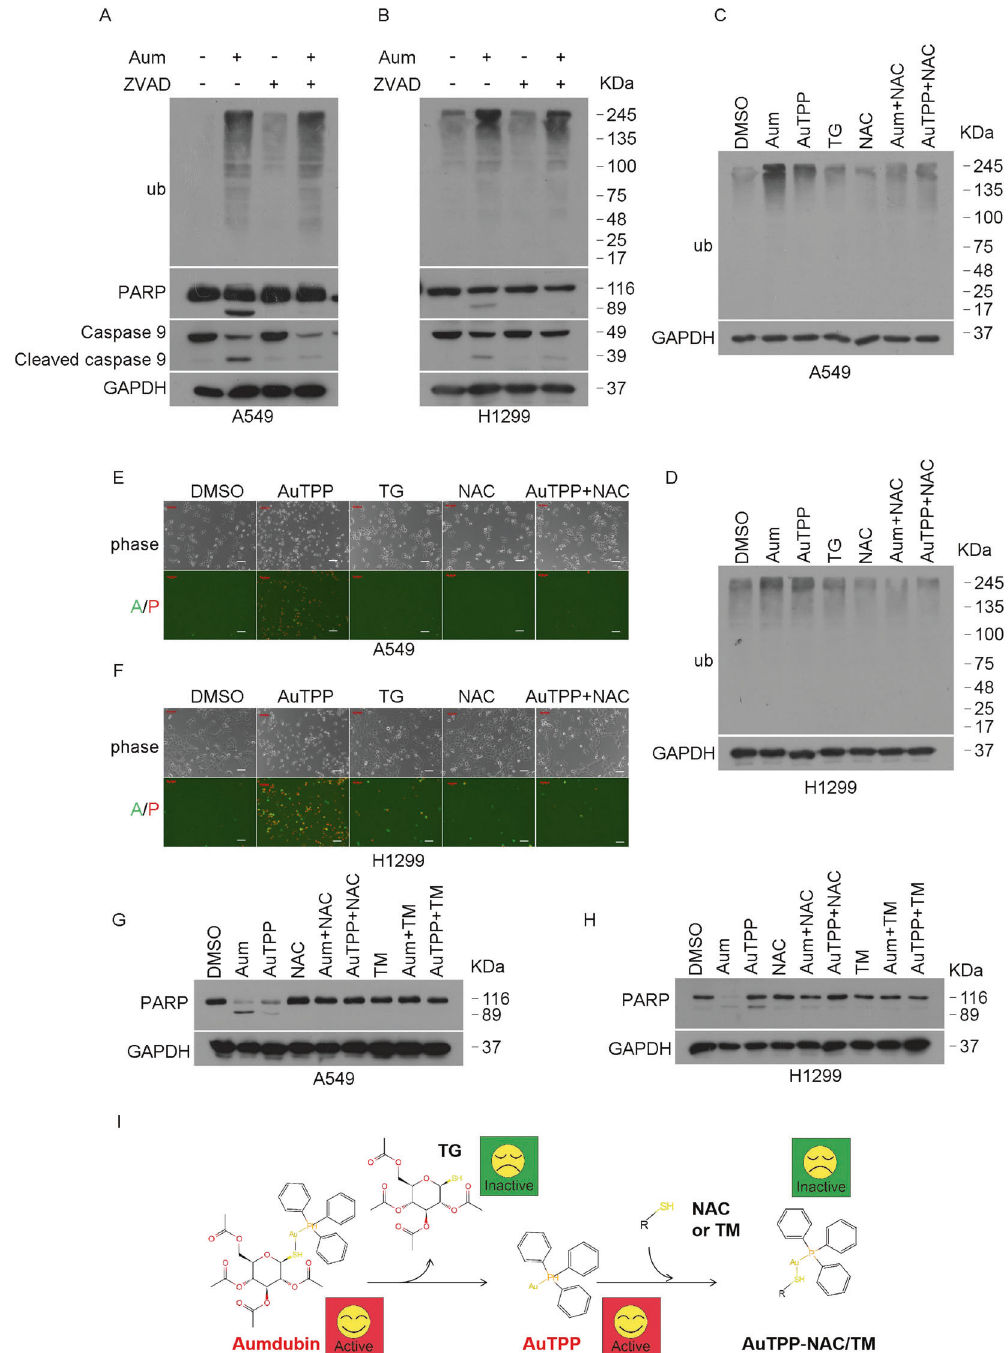
Fig. 4 DUB inhibition contributes to the apoptosis-inducing effects of aumdubin in A549 and H1299 cells. A , B Z-VAD-FMK blocks aumdubin-induced apoptosis, but not accumulation of ubiquitinated protein. A549 ( A ) and H1299 ( B ) cells were incubated with 1 μ M aumdubin (Aum) in the absence or presence of 50 μ M Z-VAD-FMK (ZVAD) for 24 h, and then ubiquitinated proteins, PARP and caspase-9 cleavage were detected using western blotting. GAPDH was used as a loading control. C , D AuTPP but not TG induces the accumulation of ubiquitinated protein. A549 ( C ) and H1299 ( D ) were treated with the indicated doses of aumdubin, AuTPP, TG in the absence or presence of 5 mM NAC for 6 h, ubiquitinated proteins were detected using western blotting. E , F NAC inhibits AuTPP-induced apoptosis. A549 ( E ) and H1299 ( F ) were treated with aumdubin in the absence or presence of 5 mM NAC for 24 h, and then cells were stained with Annexin V-FITC/ propidium iodide (A/P) and imaged under a fl uorescent microscope. The typical fl uorescent images were shown. Scale bars, 50 µm. G , H NAC and TM inhibits aumdubin and AuTPP-induced apoptosis. A549 ( G ) and H1299 ( H ) were treated with the indicated doses of aumdubin or AuTPP in the absence or presence of NAC or TM for 24 h, PARP was detected using western blotting. I Potential binding reaction between NAC or TM and aumdubin. Aumdubin may dissociate into TG and AuTPP. NAC or TM may bind with AuTPP to form new products, which lose the ability to induce apoptosis and DUB